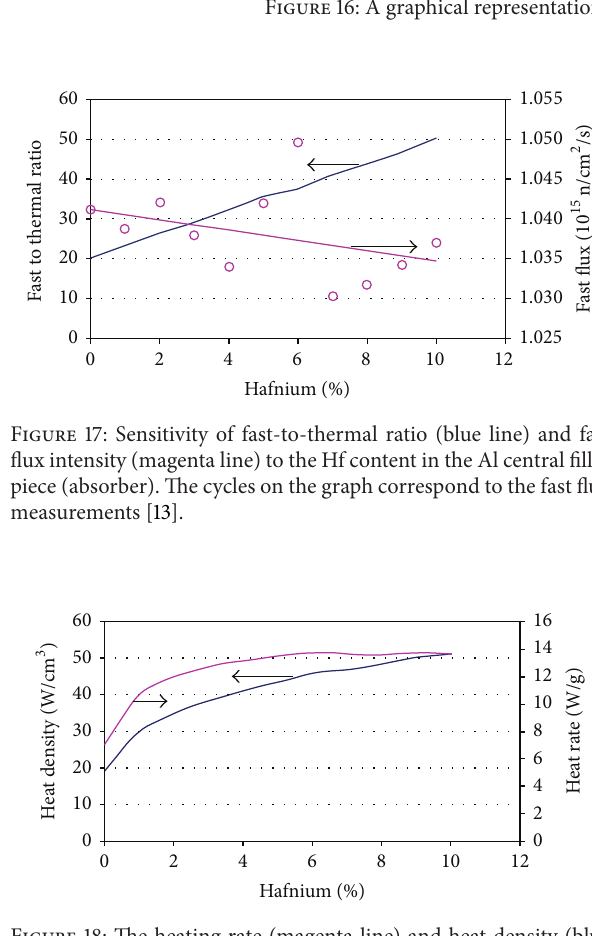
Figure 18: The heating rate (magenta line) and heat density (blue line) of the Hf-Al averaged over the central 40cm (16 inches) of the core height [14].